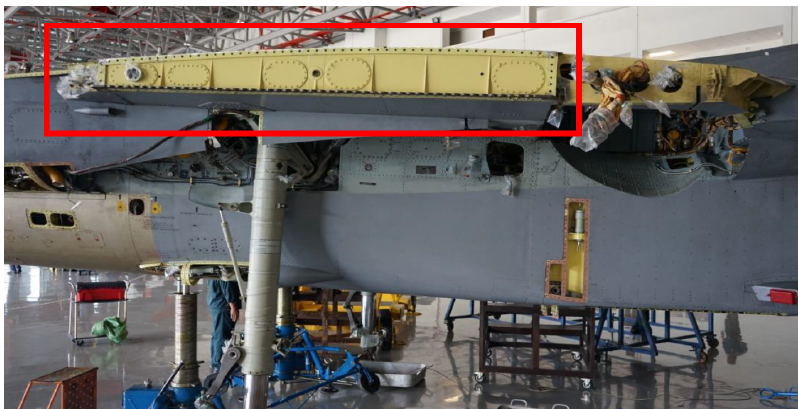
Figure 3. General wing root area.